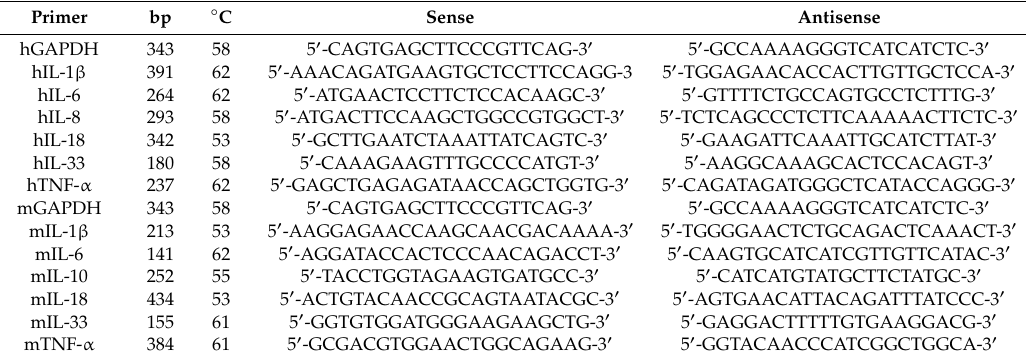
Table 3. Primer sequences. bp, base pair of product sizes; ◦ C, annealing temperature; h, human; m, mouse; GAPDH, glyceraldehyde 3-phosphate